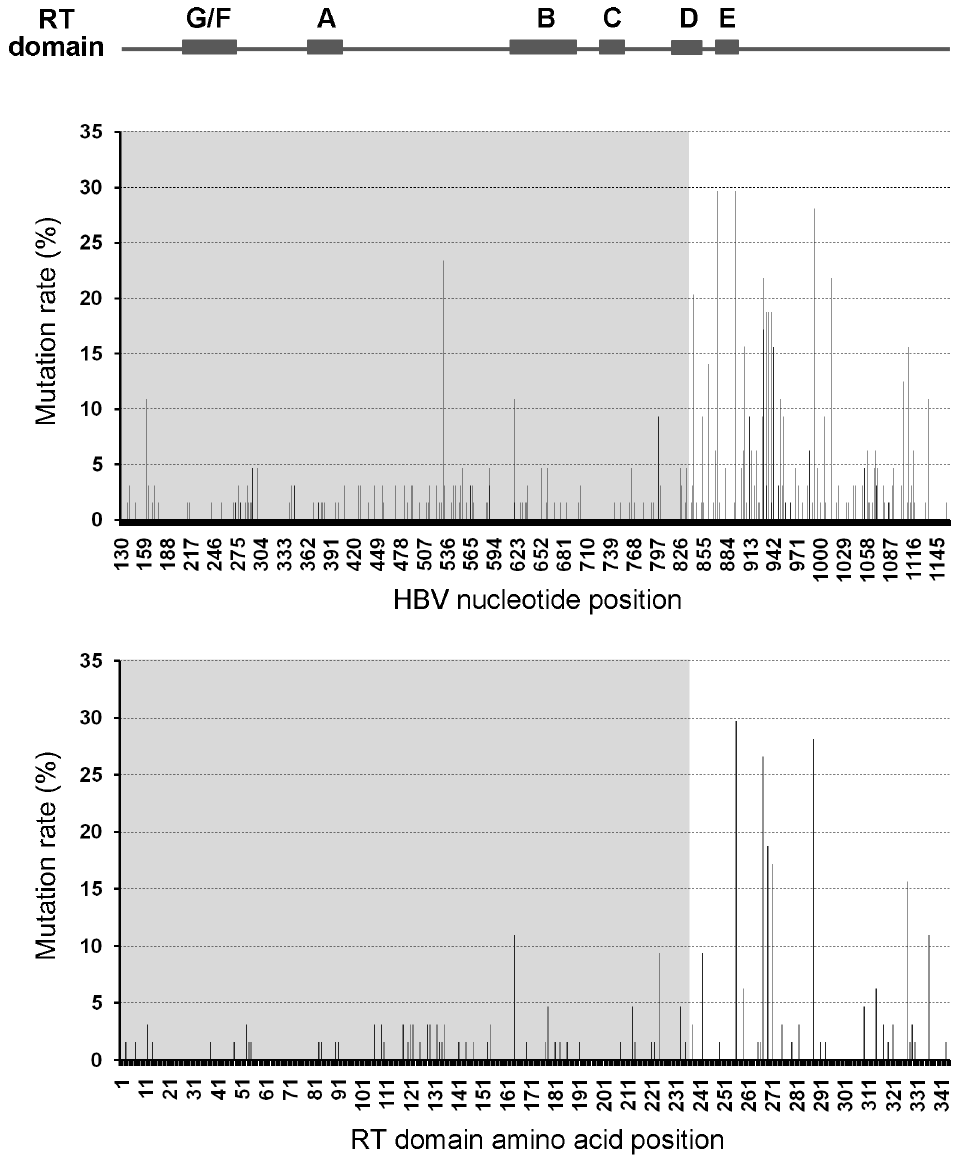
Figure 2. Frequency of nucleotide mutations and amino acid substitutions within HBV RT domain ( n =64). The values are presented as the percent nucleotide mutations (upper panel) or amino acid substitution (lower panel) compared to the wild-type genotype C hepatitis B virus (HBV) DNA sequence. The locations of the domains (A–F) are shown at the top of the figure. The pre-S/S-overlapping region in the polymerase gene is identified by grey areas. Abbreviation: HBV, hepatitis B virus; RT, reverse